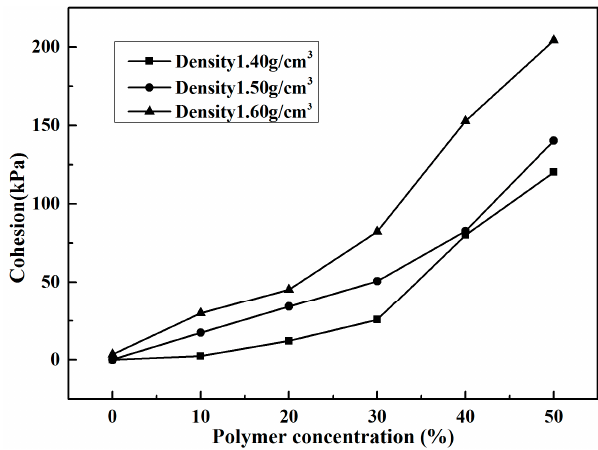
Figure 9. The variations of the cohesion of reinforced specimens with polymer concentration.